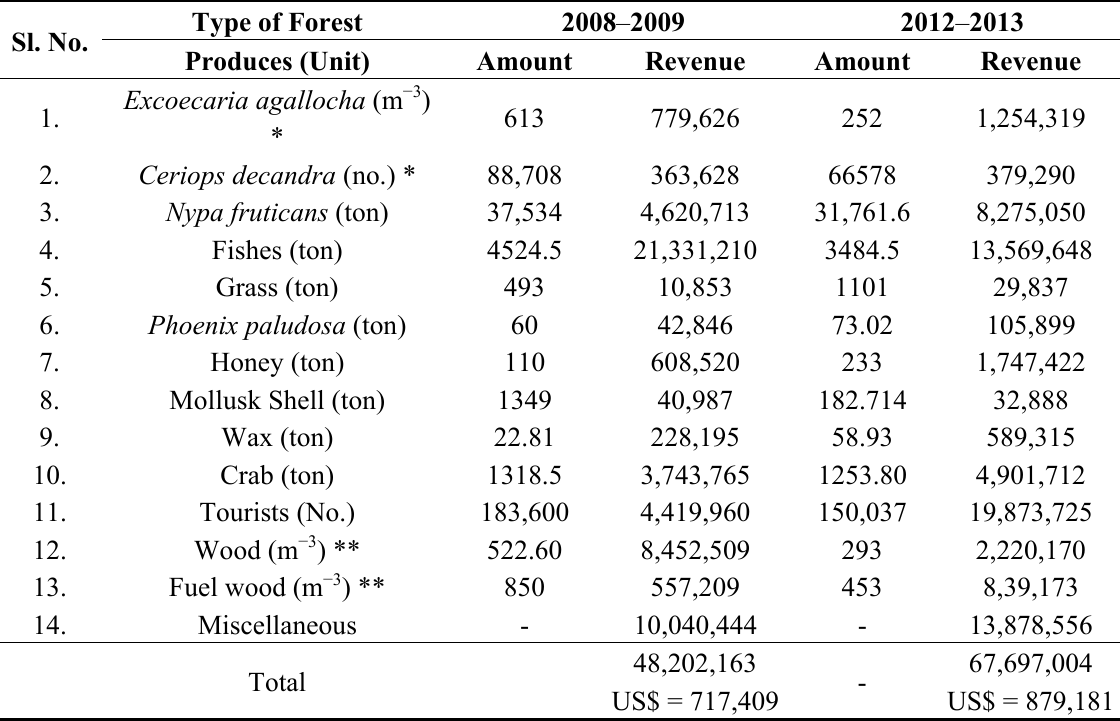
Table 6. Forest products and revenue (in BDT) obtained during 2008 to 2009 and 2012 to 13 from the